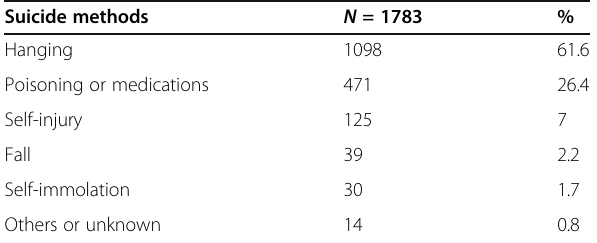
Table 3 Methods of suicide deaths in East Azerbaijan Province based on DRIS during the period 2007-2018 Suicide